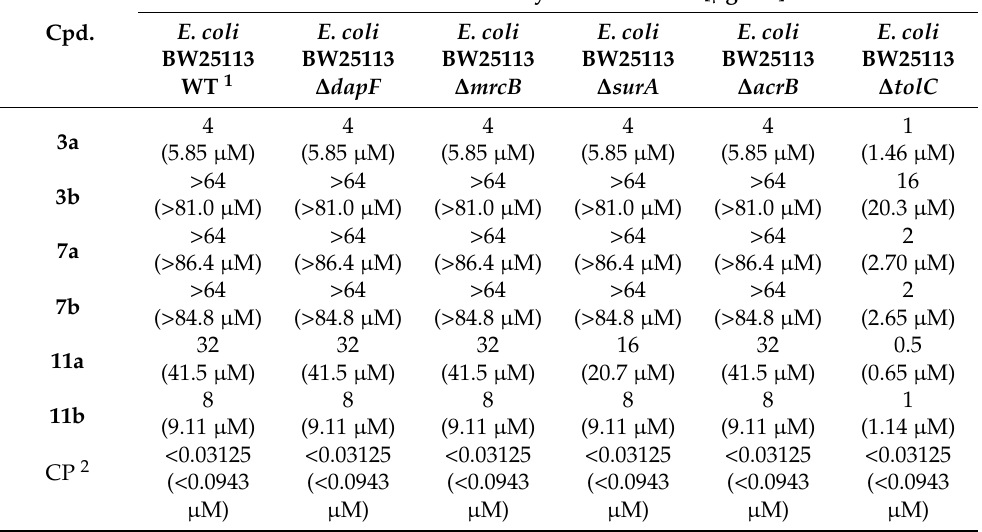
Table 3. Minimum inhibitory concentrations of these new hybrid compounds against E. coli BW25113 wild-type and mutant strains with impaired cell-wall structure ( ∆ dapF , ∆ mrcB , ∆ surA ) and efflux pumps ( ∆ acrB , ∆ tolC